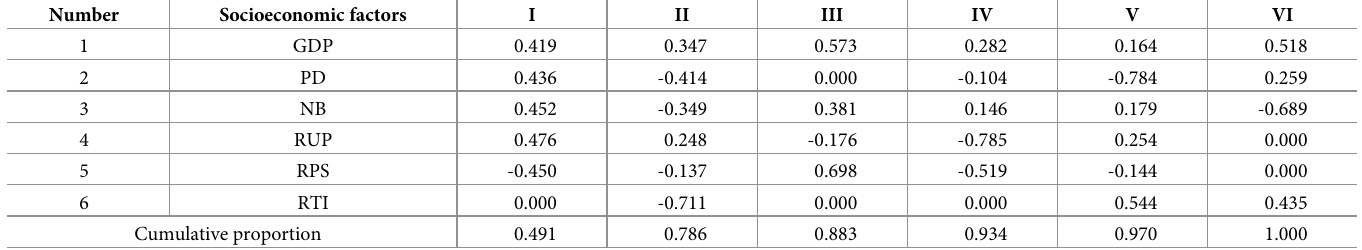
Table 5. Loadings and cumulative proportion of the principal component